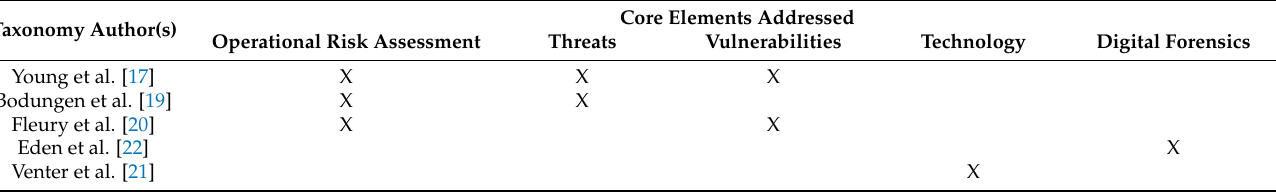
Table 2. The relationship between the taxonomies and core elements.